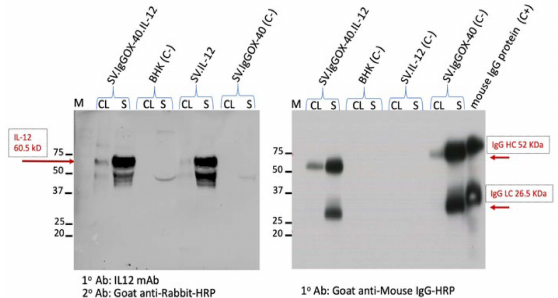
Figure 2. Expression of IL-12 (left) and α OX40 IgG (right) from SV.IgGOX40.IL-12. Western blots were performed for cell lysates (CL) and supernatant media (S) from BHK cells electroporated with SV.IgGOX-40.IL-12 mRNA, SV-expressing IL12, or ⍺ OX40 as positive controls. Unelectroporated BHK cell line was used as negative control. M: molecular weight standard . Left panel shows blot incubated with mAb to IL-12 and right panel shows blot after incubation with Ab to IgG; commercial mouse IgG antibody served as positive control. After IgG-HRP incubation, blots were developed by chemiluminescence. Blots show expression of the correct size bands.